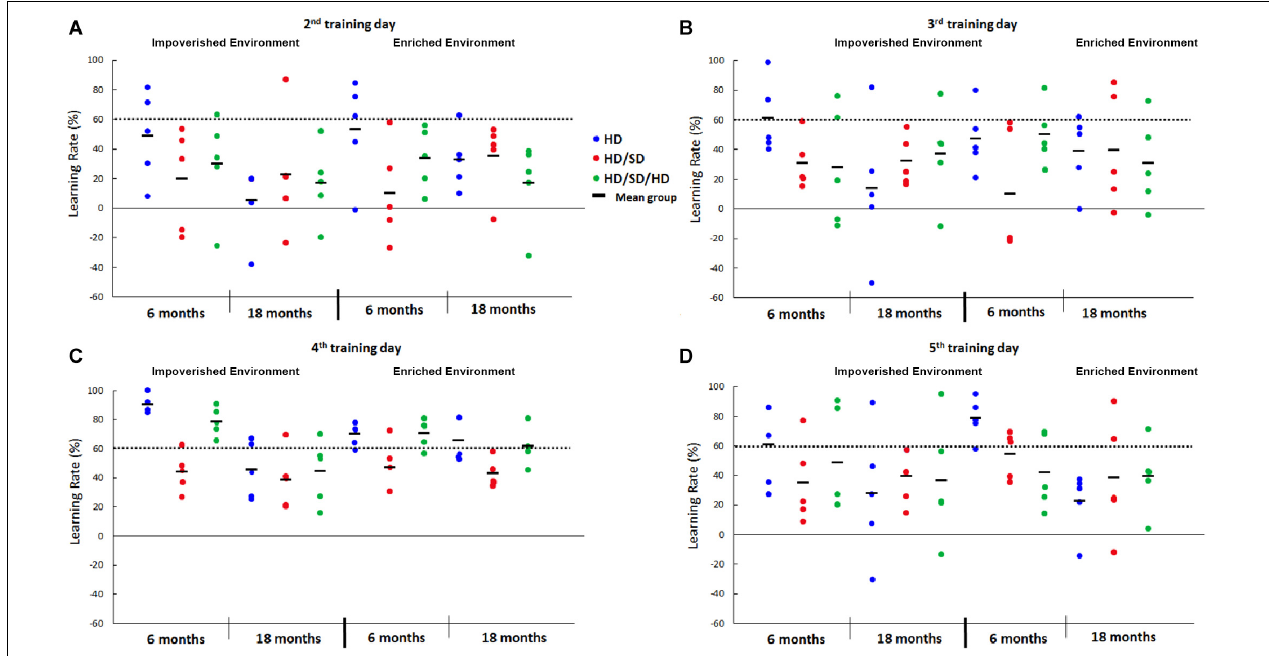
FIGURE 2 | Learning rate percentage (%) from the 2nd to 5th day in the Morris Water Maze test under different diet regimes (HD, HD/SD, and HD/SD/HD), environmental conditions (impoverished and enriched) and age (6 and 18 months). Graphic representation of individual performances (colored solid circles) and group means (dark lines between solid circles). (A) Graphic representation of individual learning rates at the 2nd testing day. (B) Graphic representation of individual learning rates at the 3rd testing day. (C) Graphic representation of individual learning rates at the 4th testing day. (D) Graphic representation of individual learning rates at the 5th testing day. HD, hard diet/pellet food and SD, soft diet/powder